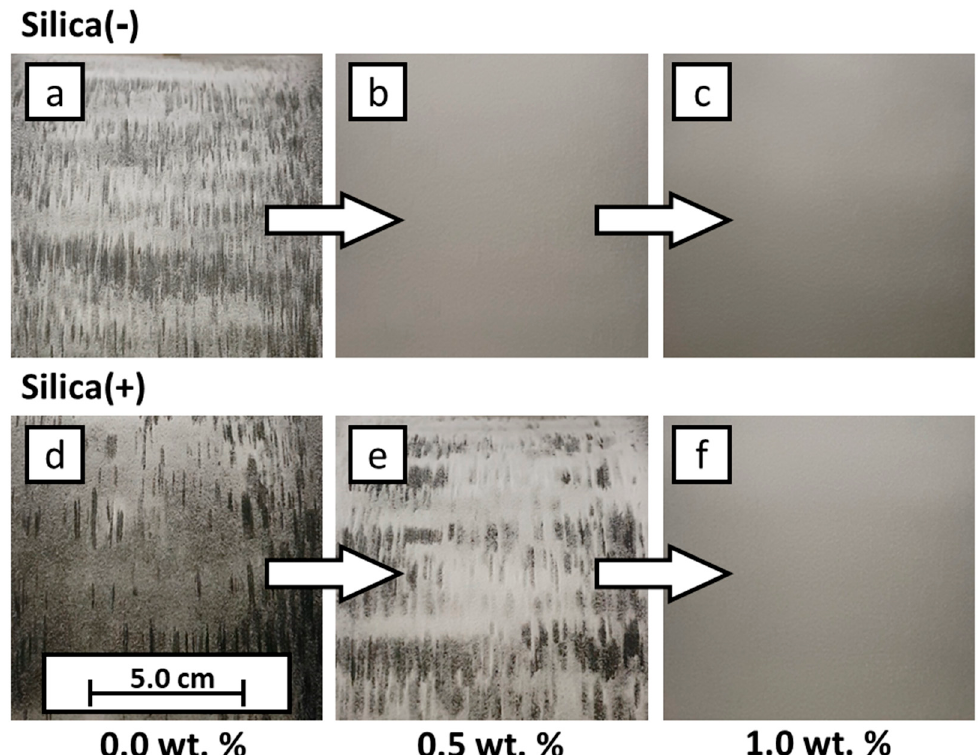
Figure 8. Results of electrophotographic powder deposition. Extracts from the image evaluation showing the powder distribution on the transfer roll. The corresponding degrees of coverage are listed in Table 3. ( a ) raw PP, transfer roll with positive electric field; ( b ) formulation 1.2, transfer roll with positive electric field; ( c )) formulation 5.2, transfer roll with positive electric field; ( d ) raw PP, transfer roll with negative electric field; ( e ) formulation 6.2, transfer roll with negative electric field; ( f ) formulation 10.2, transfer roll with negative electric field.